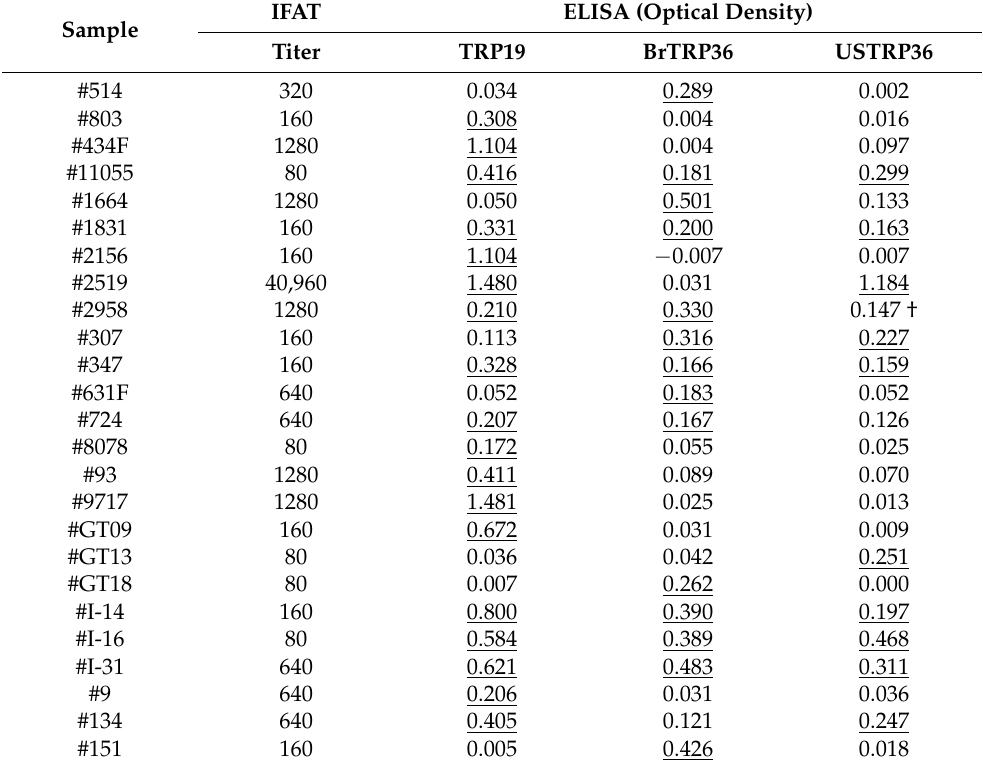
Table 1. Detection of Ehrlichia canis antibodies in feline serum samples subjected to the indirect fluorescence antibody test (IFAT) with Ehrlichia canis antigens, and enzyme-linked immunosorbent assay (ELISA) with synthetic peptides TRP19, BrTRP36 and USTRP36.